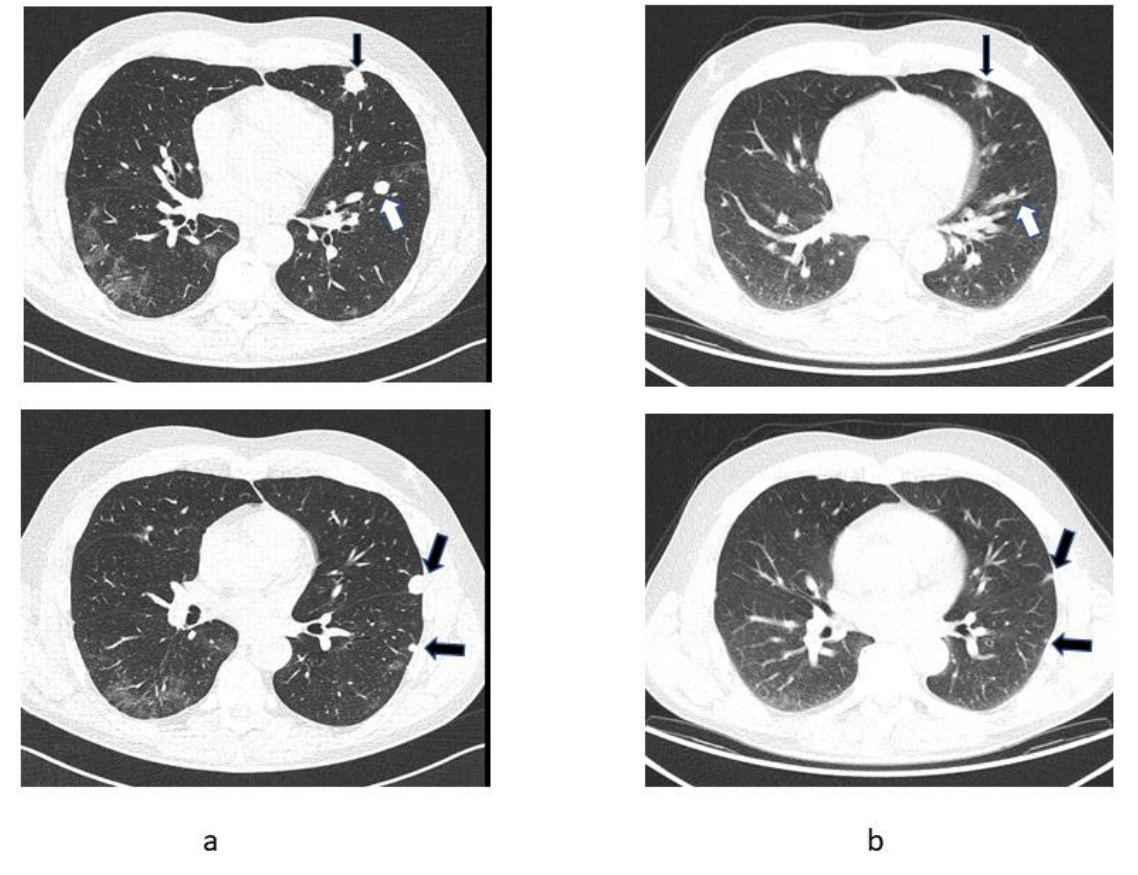
Figure 2. Sequential chest CT images of Patient 2 showing partial regression of pulmonary metastases (arrows). ( a ) CT scan of 15 April 2021, ( b ) CT-registered images from PET/CT scan of 20 July 2021.